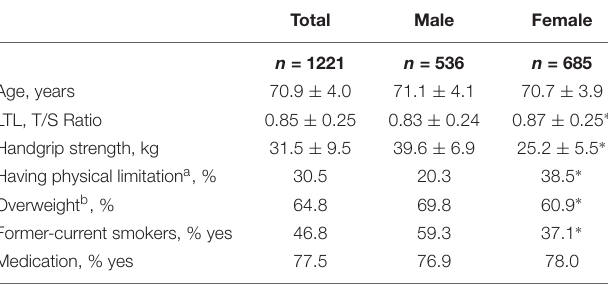
TABLE 1 | Characteristics of the study sample by gender.